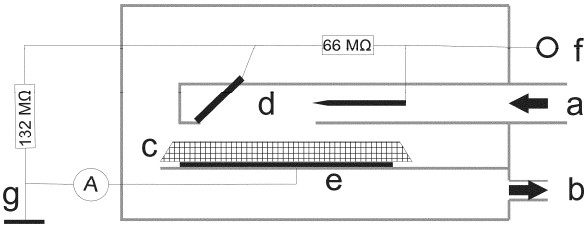
Fig. 2. Two-stage electrostatic precipitator for deposition of aerosol particles onto ATR crystals: a – aerosol inlet; b – vacuum pump (operated at a flow rate between 0.3-3 dm 3 min - 1) ; c – ATR crystal; d – charging and deposition zone; e – copper electrode; f – high voltage supply; g – ground connection; A – electrometer for control of electric current flowing off the ATR crystal.